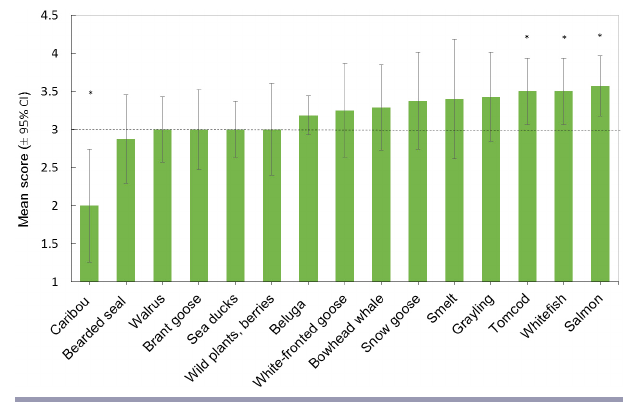
Fig. 6 . Relative change in availability of subsistence resources as perceived by workshop participants in Wainwright, Alaska. Resources were assessed on a scale of 1 (strong decrease in availability) to 5 (strong increase in availability), with a score of 3 indicating no change. Bars extending above the dotted line indicate that availability has increased; bars ending below the dotted line indicate that availability has decreased. Asterisks denote species or groups where 95% confidence intervals do not overlap 3. Data were collected during workshop 4 from 9